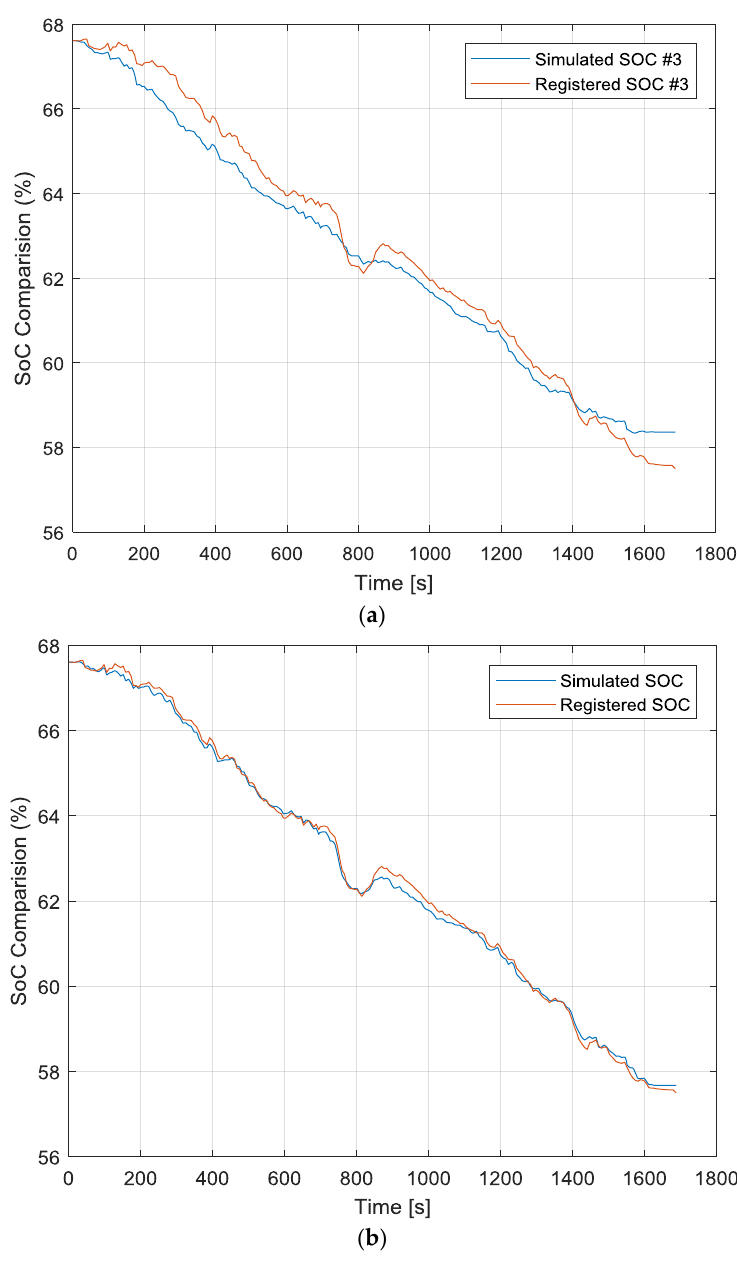
Figure 15. Trip #3 ( a ) Driving events, shown in Figure 13, are not considered in this scenario ( b ) Driving events are considered in this scenario.